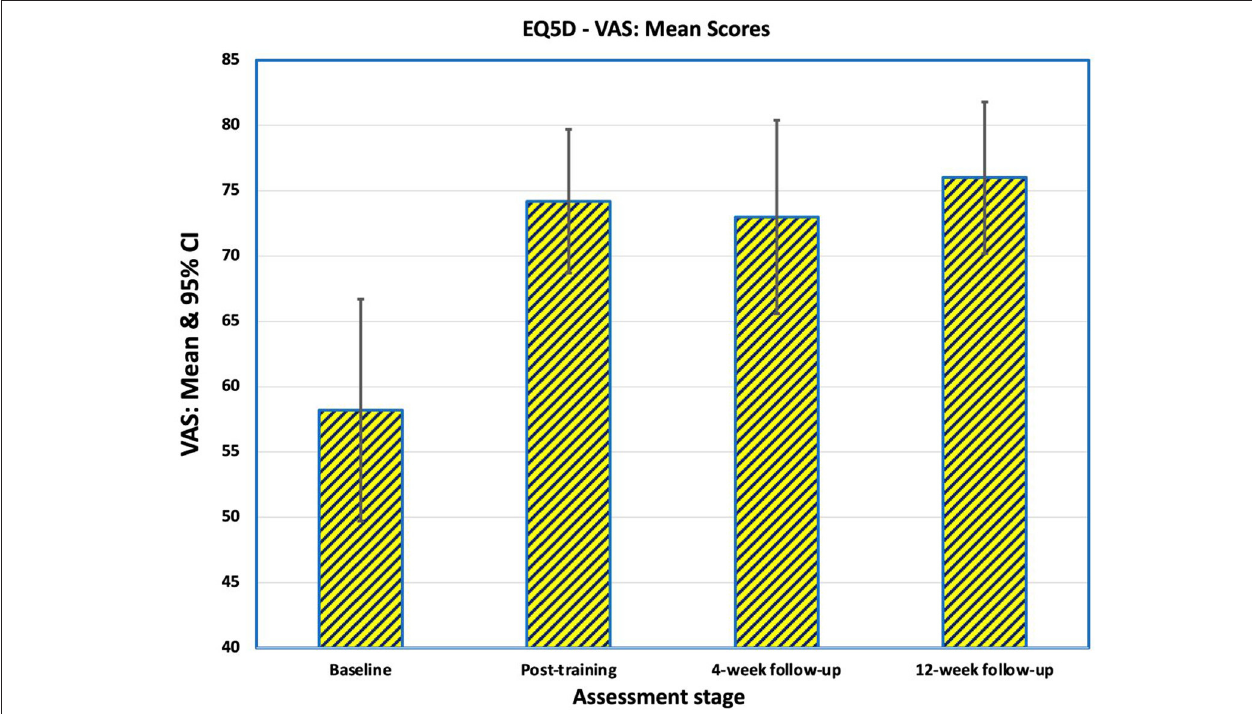
FIGURE 9 | Mean scores of the 16 participants on the EQ-5D VAS captures the respondent’s overall assessment of their health on a scale from 0 (worst health imaginable) to 100 (best health imaginable). After training 11 participants rated themselves as better, two were the same and three were worse compared to baseline. At the 4-weeks follow-up, 12 were better, three were the same and one was worse. At the end of the study, 12 were better, four were not improved from baseline and none were